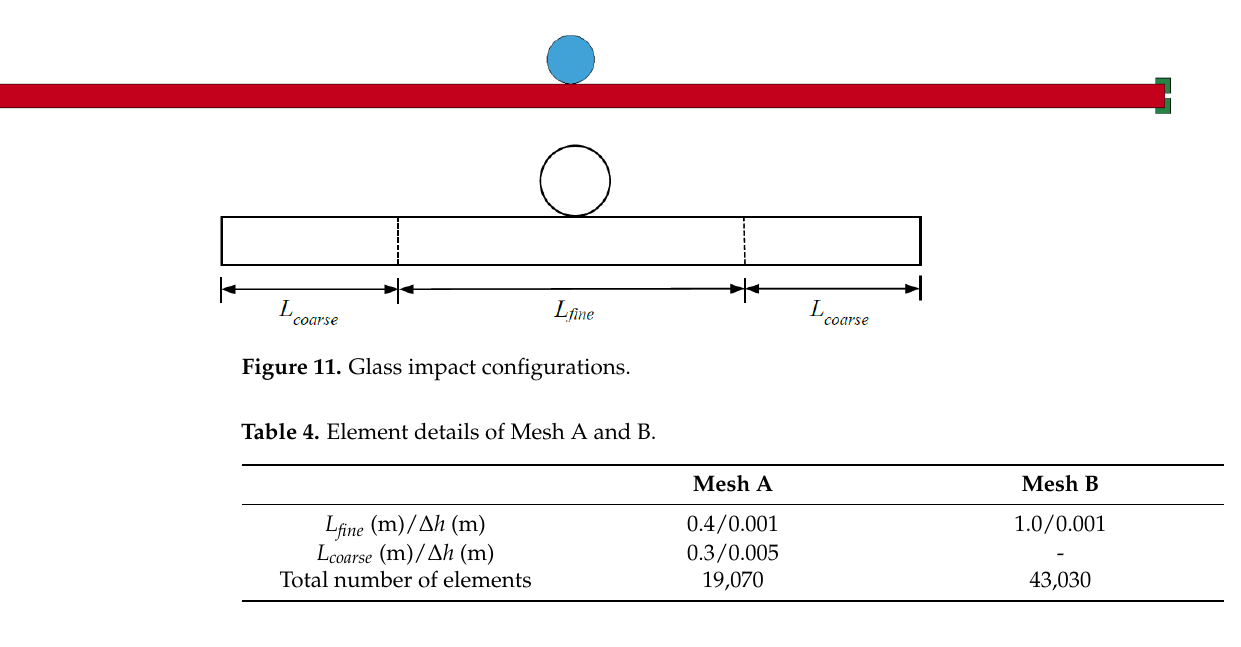
Table 5. Material properties for FDEM simulations.